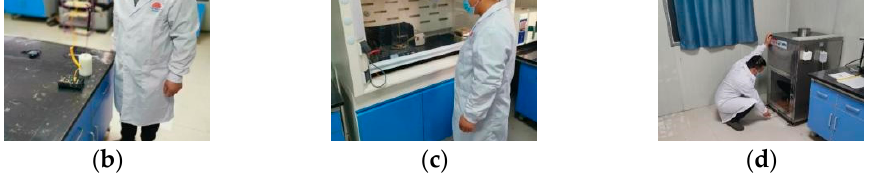
Figure 4. Laboratory test diagram. ( a ) Curing time test; ( b ) reaction temperature; ( c ) flashpoint test; ( d ) flame-retardant performance test. Table 2. Technical index of grouting material.